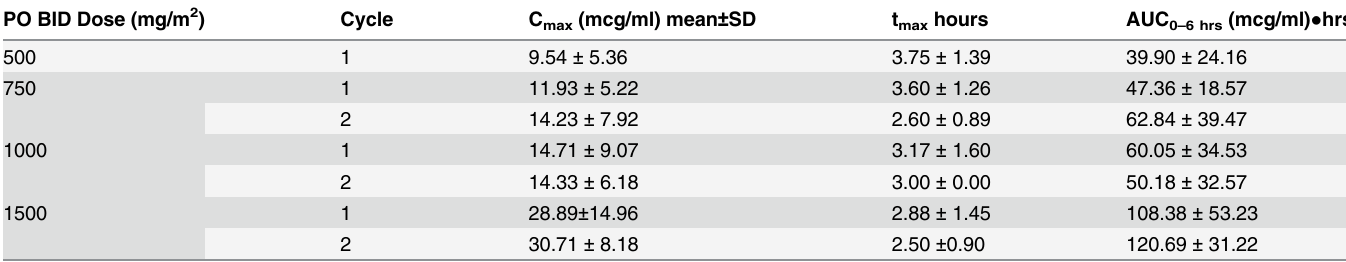
Table 3. DFMO Pharmacokinetic Parameters (mean ± SD) by Dose Level. PO BID Dose (mg/m 2